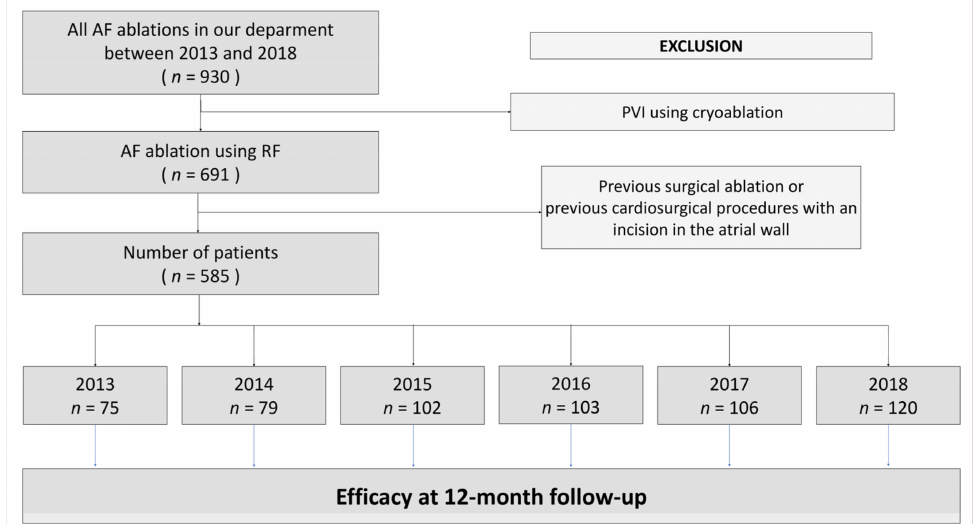
Figure 1. Study flow chart. Abbreviation: AF—atrial fibrillation, PVI—pulmonary vein isolation, RF—radiofrequency